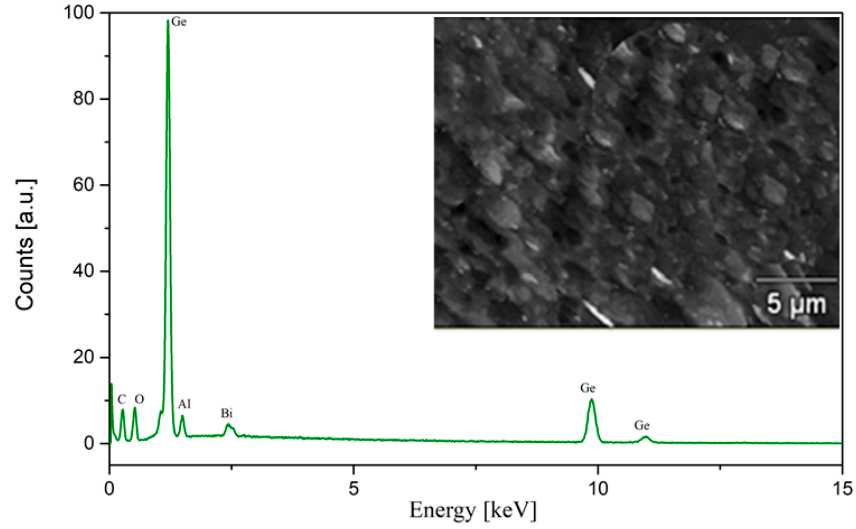
Figure 4. An example of EDXS analysis spectrum with SEM micrograph of examined glass.